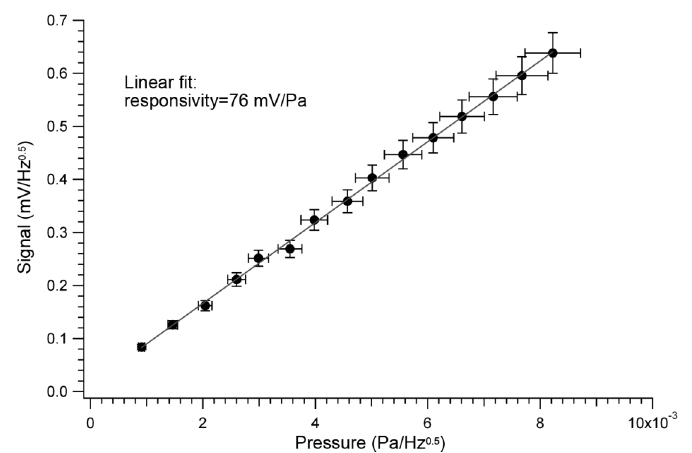
Fig. 8. FL output signal versus pressure (measured with the calibrated reference hydrophone). FL optical pow- er 10 µ W, test note frequency 40 kHz; OPD ∼ 450 m. Error bars represent the reading uncertainty.